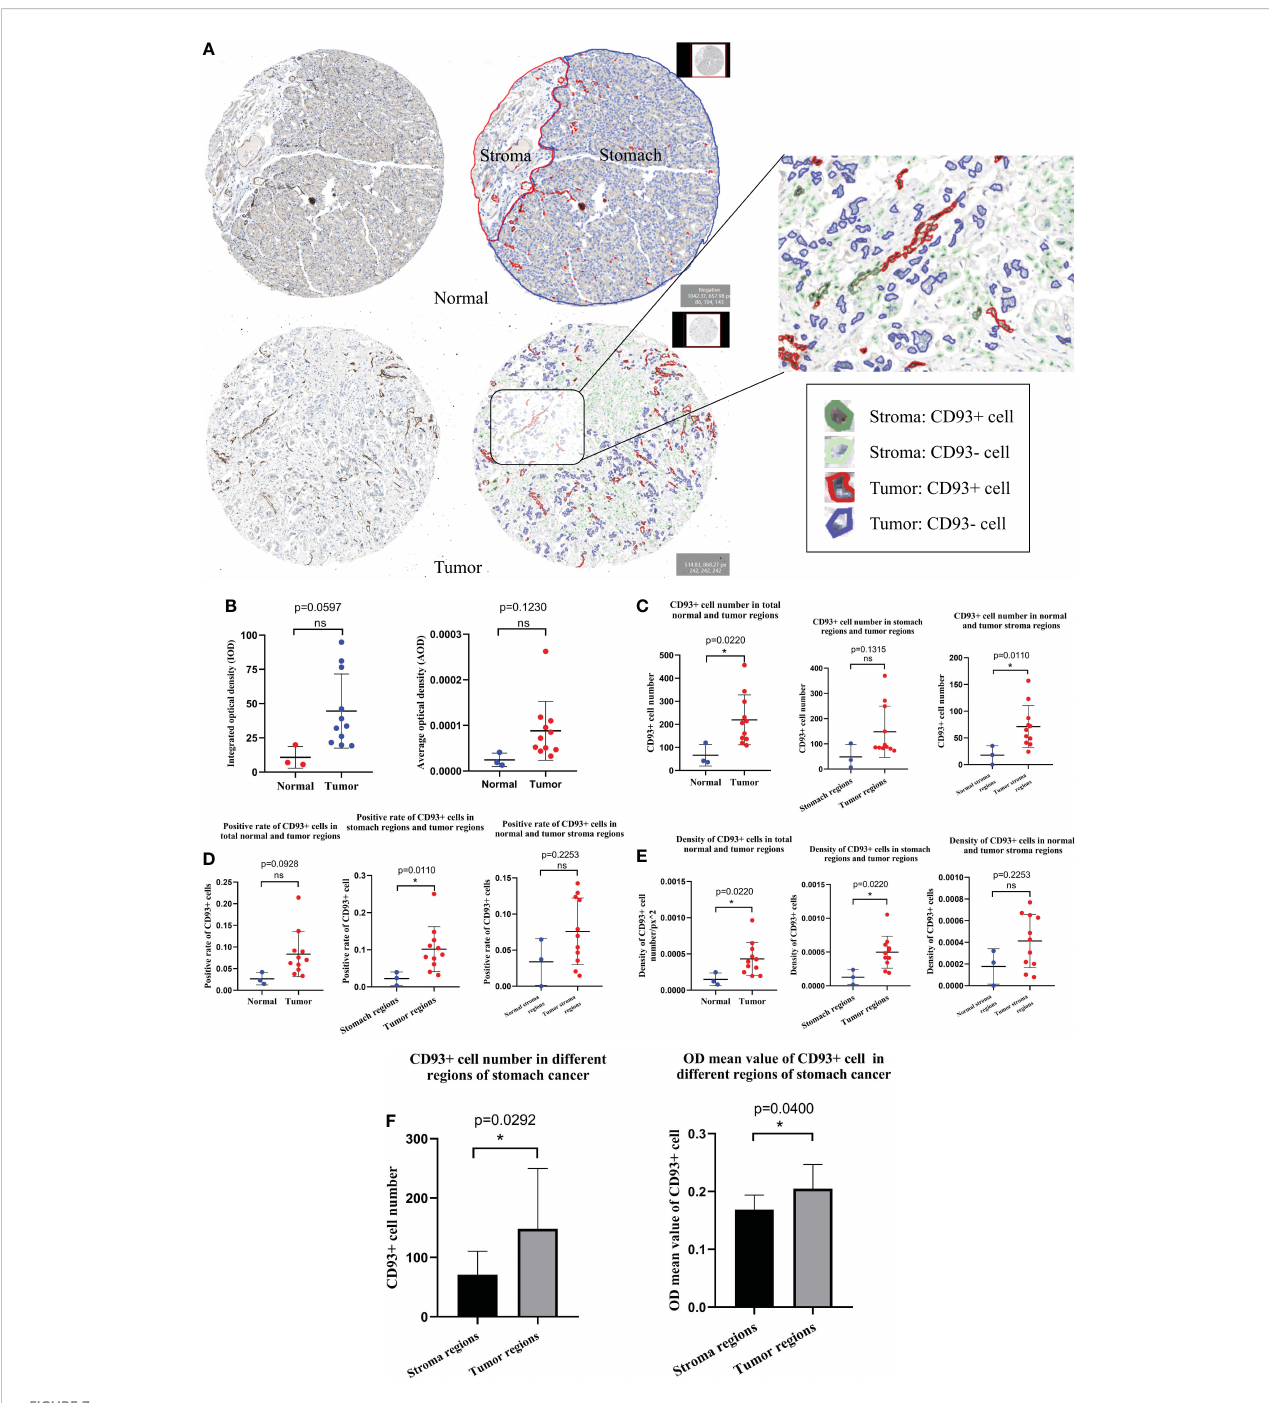
FIGURE 7 Human Protein Atlas immunohistochemical staining image analysis results by QuPath. (A) Results of tissue segmentation and cell recognition of stomach cancer and normal stomach tissue. (B) The integral optical density and average optical density of CD93 + cells in stomach cancer and normal stomach tissue were statistically signi fi cant. The CD93 + cell number (C) , positive rate (D) , and density (E) were statistically signi fi cant in different regions of stomach cancer and normal stomach tissue. (F) Contrast results of CD93 + cell number and optical density values of CD93 + cells in different regions of stomach cancer. Student ’ s t -test (meet the normal distribution) and Mann – Whitney U -tests (do not meet the normal distribution). * p < 0.05. ns, no signi fi